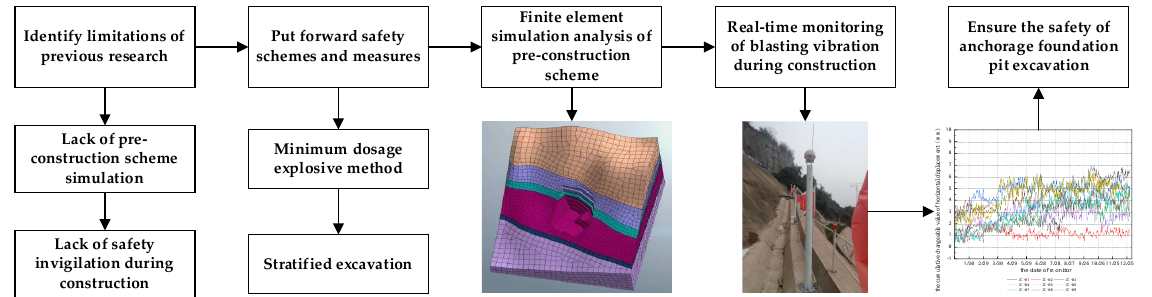
Figure 1. Flow Chart of Research Methods.